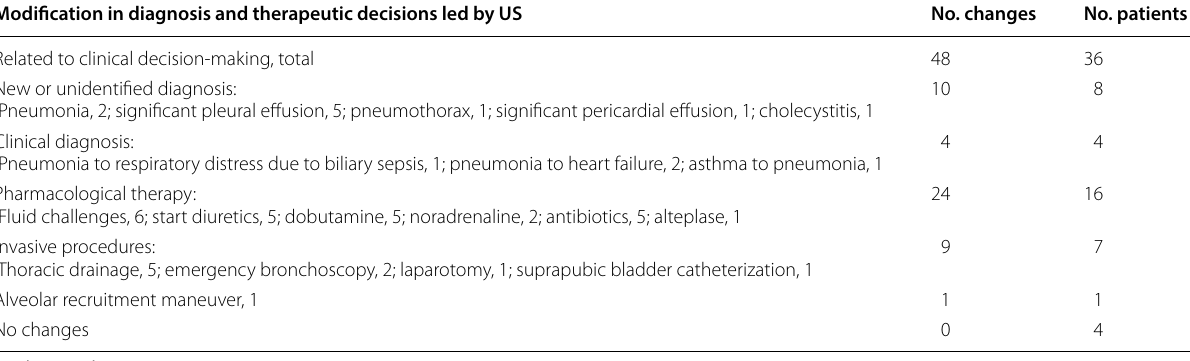
Table 3 Description of changes in clinical information or decisions led by